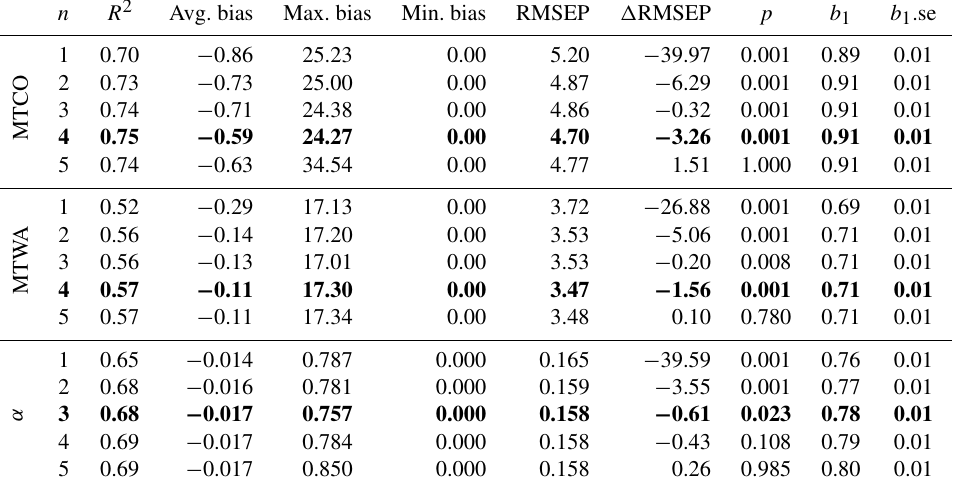
Table 2. Leave-out cross-validation (with geographically and climatically close sites removed) fitness of the modified version of fxTWA-PLS for the mean temperature of the coldest month (MTCO), mean temperature of the warmest month (MTWA) and plant-available moisture ( α ), with P-splines smoothed fx estimation, using bins of 0.02, 0.02 and 0.002, respectively; n is the number of components used; Avg.bias is the average bias, while Max.bias is the maximum absolute bias and Min.bias is the minimum absolute bias; RMSEP is the root-mean- square error of prediction; and (cid:49) RMSEP is the per cent change rate of RMSEP, which is (RMSEP n − RMSEP n − 1 ) / RMSEP n − 1 converted into percentage; when n = 1, RMSEP 0 is the RMSEP of the null model. p assesses whether using the current number of components is significantly different from using one component less, which is used to choose the last significant number of components (indicated in bold) to avoid over-fitting. The degree of overall compression is assessed by linear regression of the cross-validated reconstructions onto the climate variable; b 1 and b 1 .se are the slope and the standard error of the slope, respectively. The closer the slope ( b 1 ) is to 1, the less the overall compression